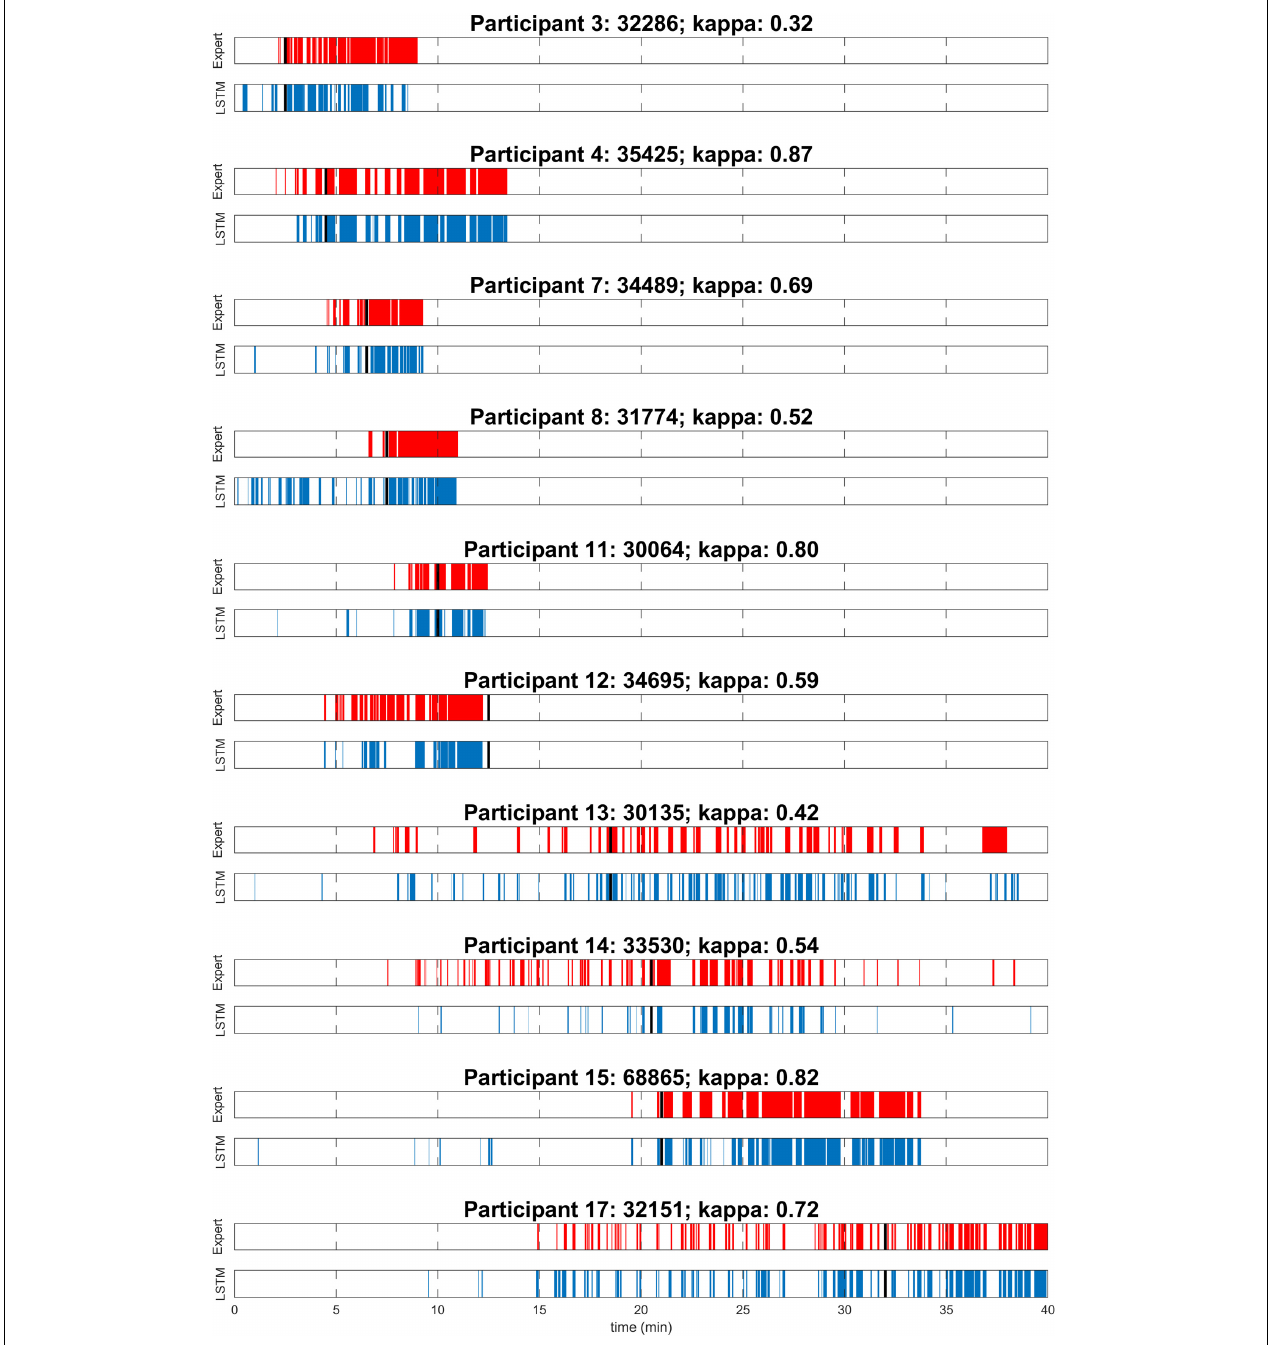
FIGURE 1 | Visual expert scoring (red) and automatic detection with long short-term memory neural network (LSTM; blue) of microsleep episodes (MSEs) for each of the 10 participants assessed in the maintenance of wakefulness test (MWT) after sleep deprivation. Sleep onset is indicated (black). Participants are numbered according to Figure 3A